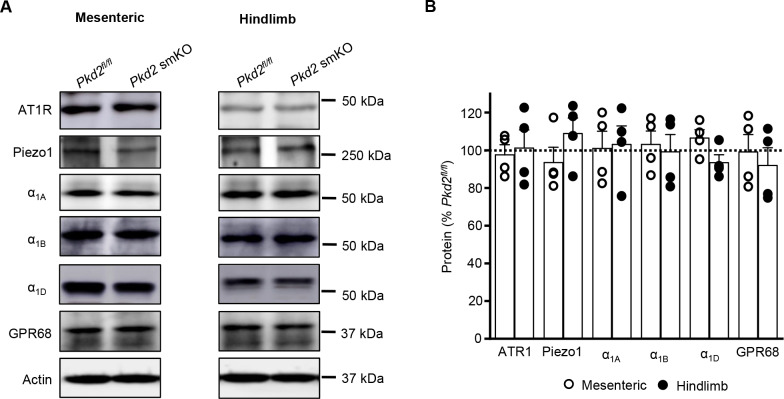
Several proteins that regulate arterial contractility are unchanged in tamoxifen-treated Pkd2fl/fl:myh11-cre/ERT2 mice.(A) Western blots illustrating Angiotensin II type one receptor (AT1R), Piezo1, α1-adrenergic receptor A (α1A), α1-adrenergic receptor B (α1B), α1-adrenergic receptor D (α1D) and G protein-coupled receptor 68 (GPR68) protein levels in mesenteric and hindlimb arteries of Pkd2fl/fland Pkd2fl/fl:myh11-cre/ERT2 mice. (B) Mean data from mesenteric and hindlimb arteries (n = 4 per group).